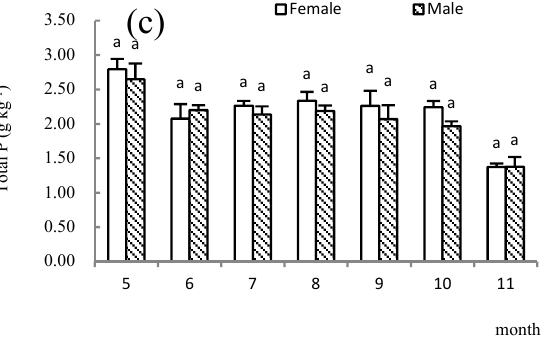
Figure 5. Comparation of C ( a ), N ( b ), P ( c ) contents in leaf of female and male plants of F. velutina during the growing season. Note: Means not sharing the same letter of female and male plants in the same month indicated significant differences between males and females at an alpha level of 0.05, according to one-way ANOVA.